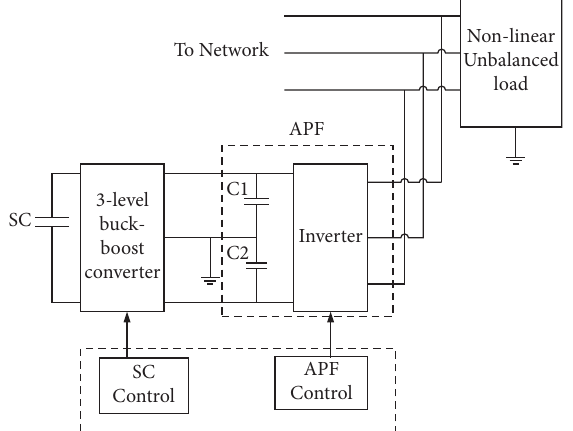
Figure 4: Te topology confguration of the SC-integrated APF